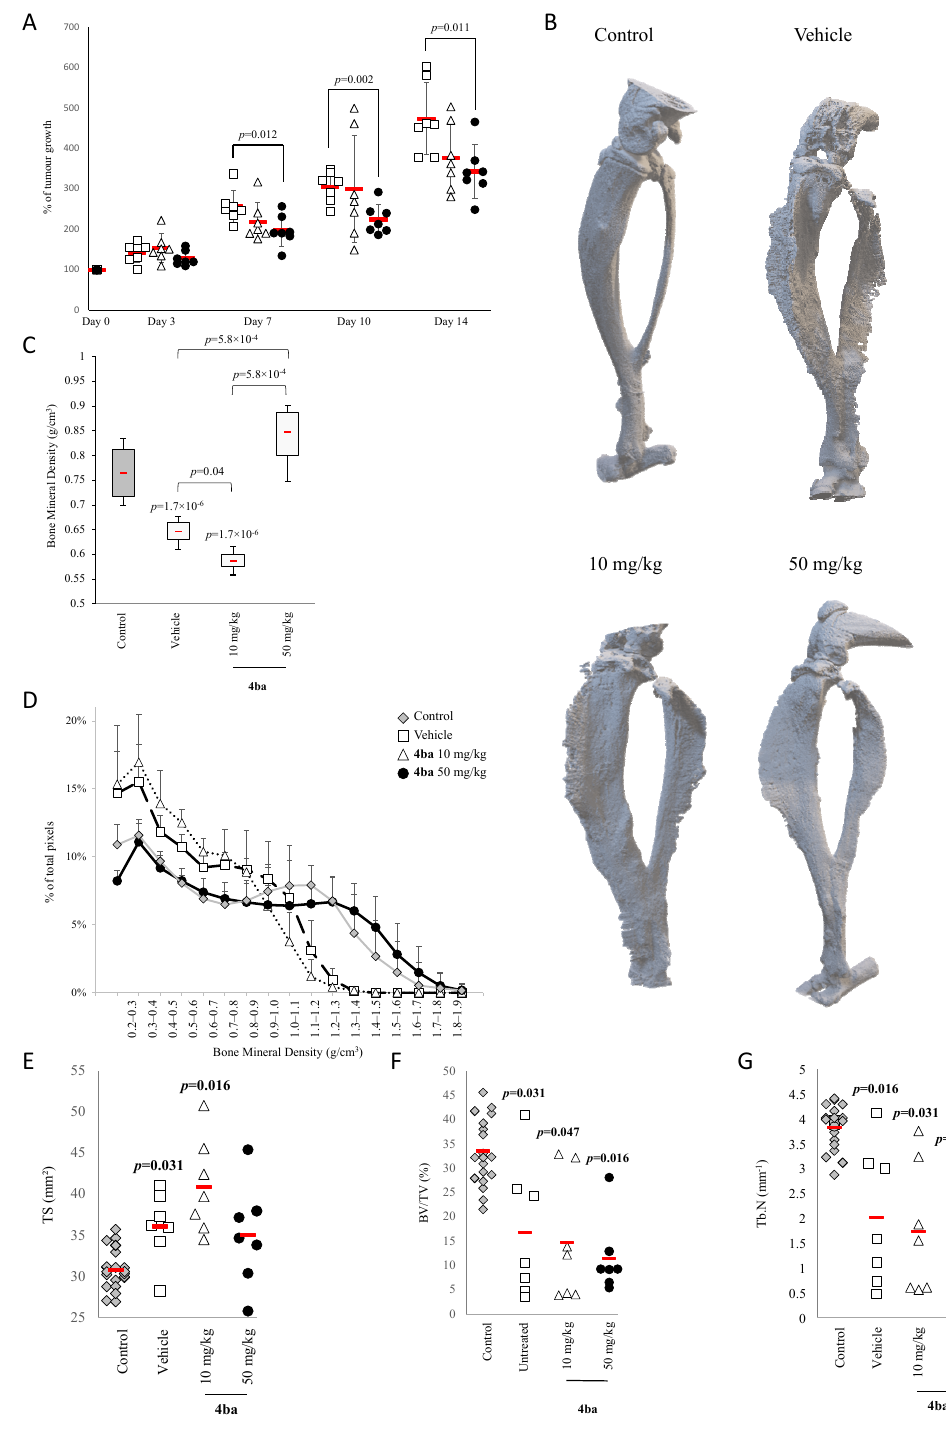
Figure 9. Pyridazinone scaffold-based molecules decrease tumor growth in an orthotopic osteosarcoma model. Tumor growth evolution after first day of treatment with vehicle alone (white square), with compound 4ba at 10 mg/kg (white triangle) and at 50 mg/kg (black circle) ( A ). Representative MicroCT imaging of tumor-bearing mice for contralateral paw (control, grey diamond), paw from mice treated with vehicle (white square), compound 4ba at 10 mg/kg (white triangle) and at 50 mg/kg (black circle) ( B ), quantification of total bone mineral density ( C ) and distribution of bone density ( D ). MicroCT quantification of local cortical surface (TS), trabecular bone volume (BV/TV) and trabecular number (Tb.N) ( E – G ). n = 21 for control and n = 7 for each other conditions. p -values are given relative to DMSO on box-plots; the brackets indicate the conditions compared.